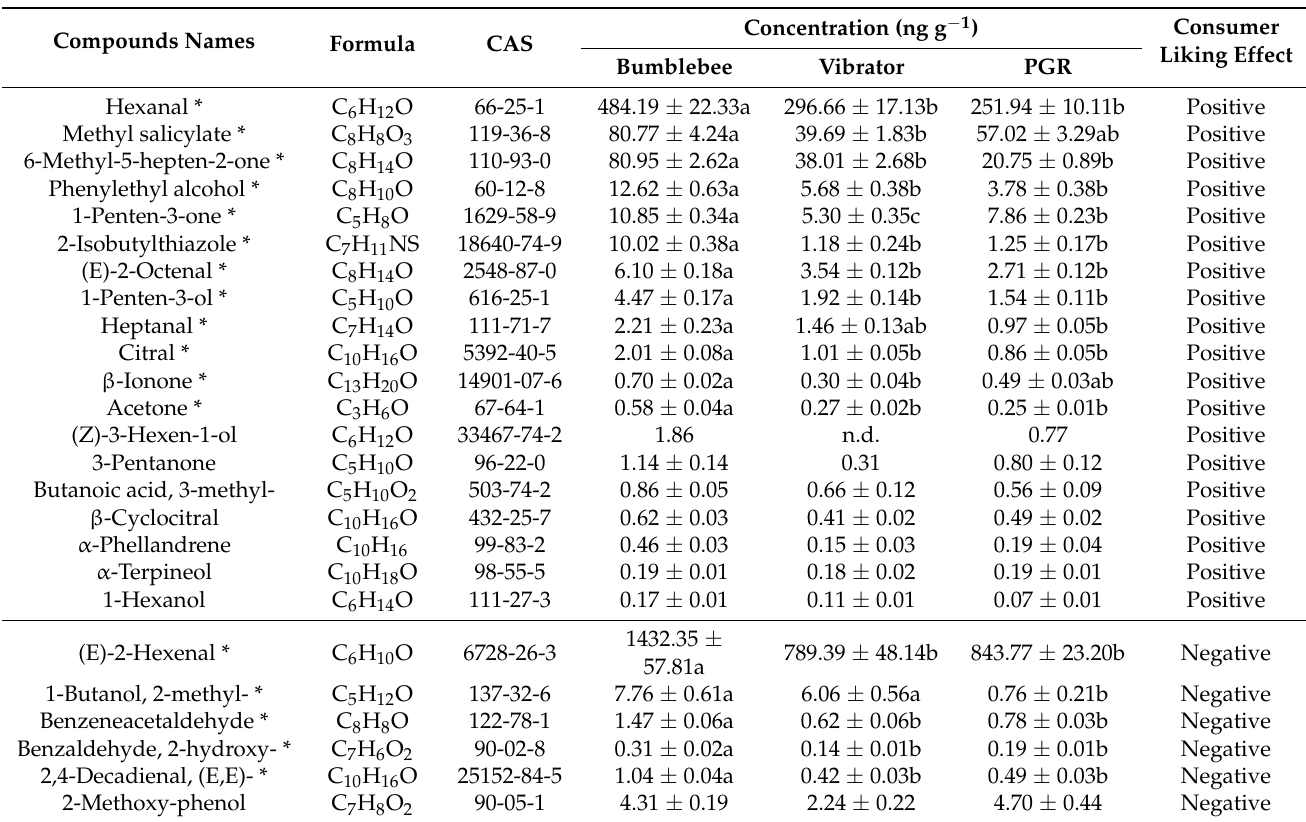
Table 1. Consumer liking related volatile organic compounds from tomato fruit by different polli- nation methods.